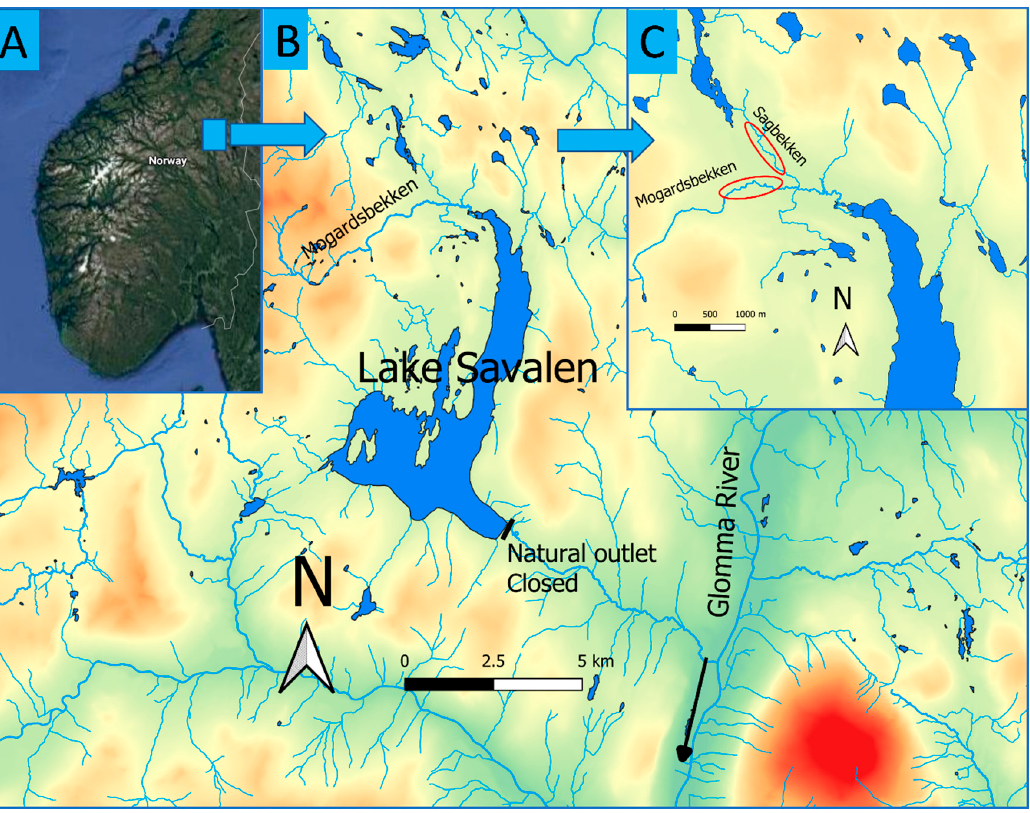
Figure 1. Approximately location of the study area in South Norway ( A ), overview of the Lake Savalen with tributaries ( B ), and a more detailed map of the sampled streams Mogardsbekken and Sagbekken ( C ), with red ellipses indicating the sampled stretches.